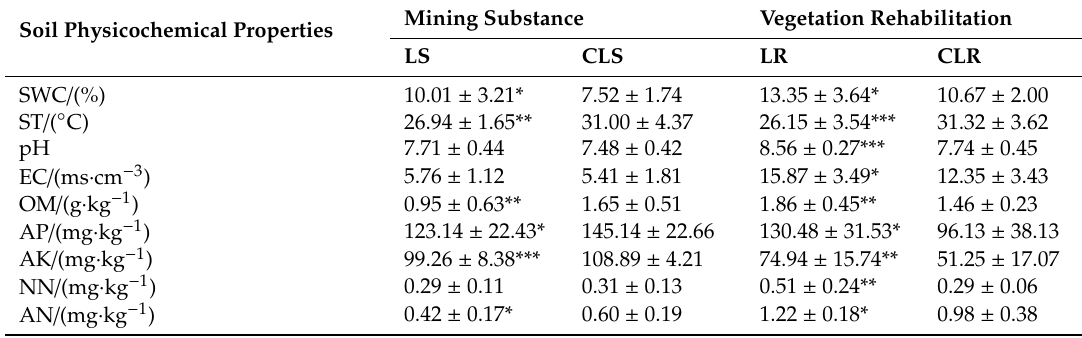
Table 1. Changes of soil physicochemical properties after mining substance and vegetation rehabilitation. Soil Physicochemical